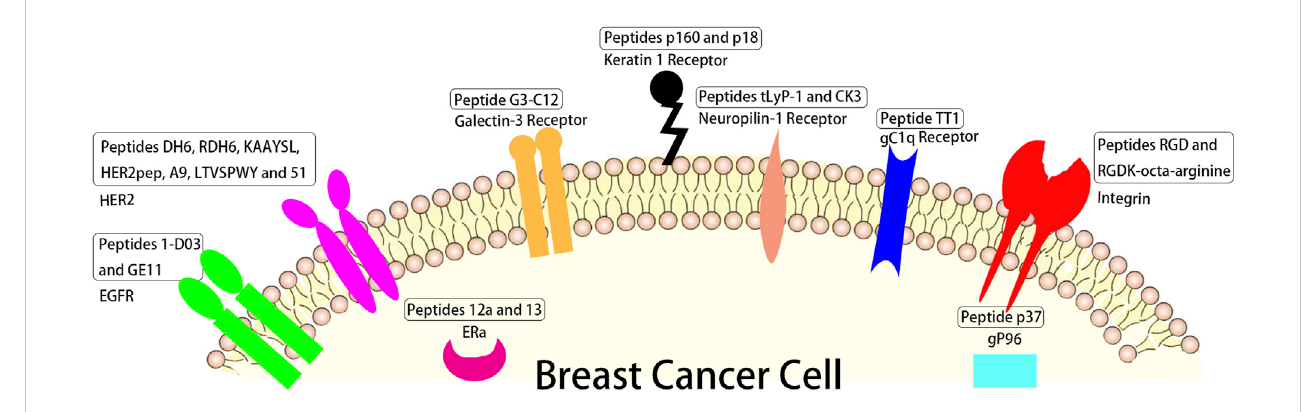
FIGURE 2 The schematic of different peptides targeting breast tumor and their corresponding targets overexpressed in breast tumor